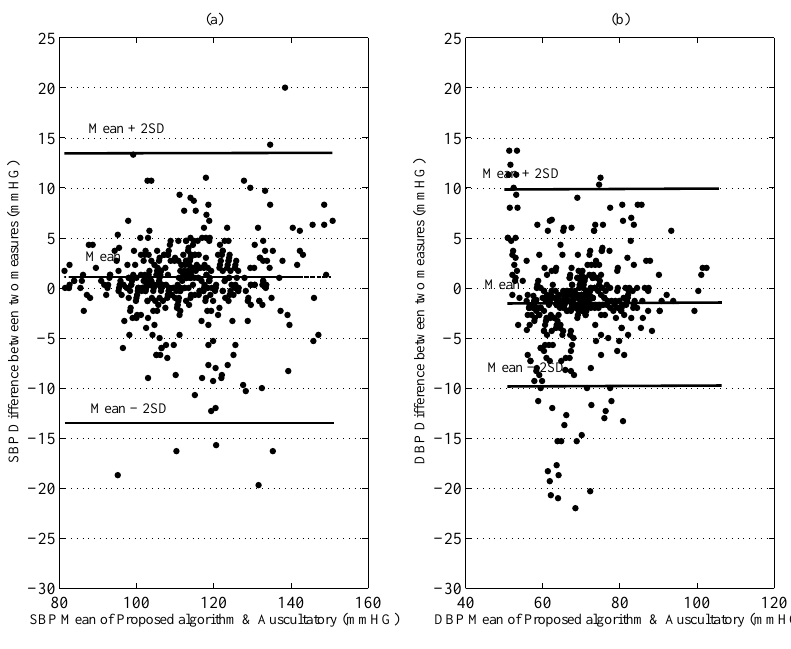
Figure 5. Bland-Altman plots comparing of the performance between the proposed (MAABG) algorithm and auscultatory results, ( a ) Bland-Altman plot for the SBP and ( b ) Bland-Altman plot for the